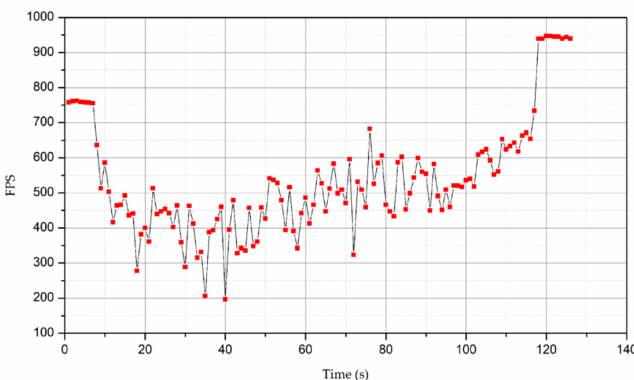
Figure 15. FPS changes during scale transition of terrain model within 2